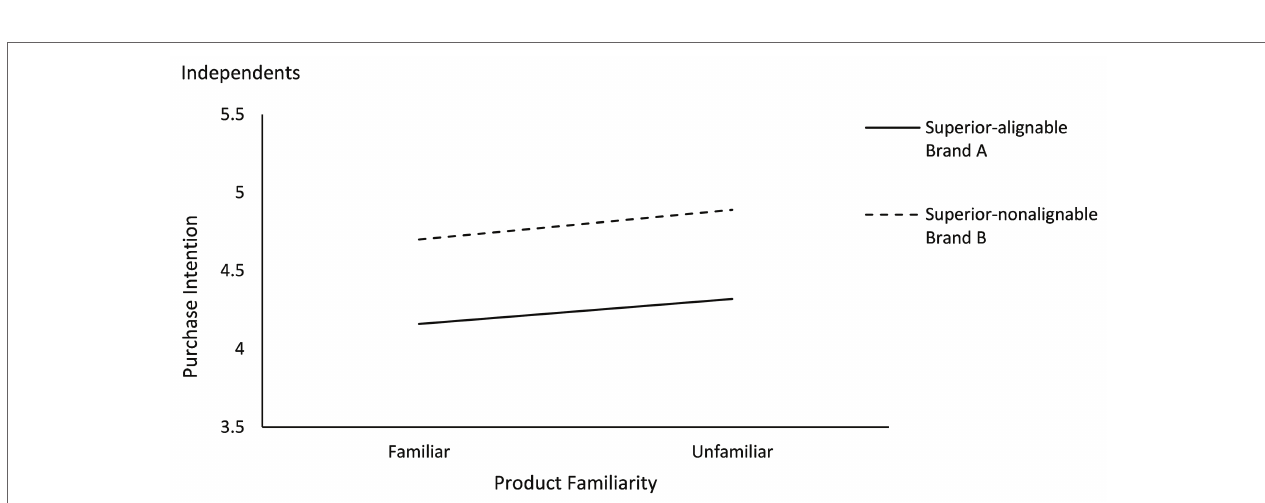
FIGURE 6 | Effects of product familiarity and attribute alignability on purchase intention for interdependents (study 3).